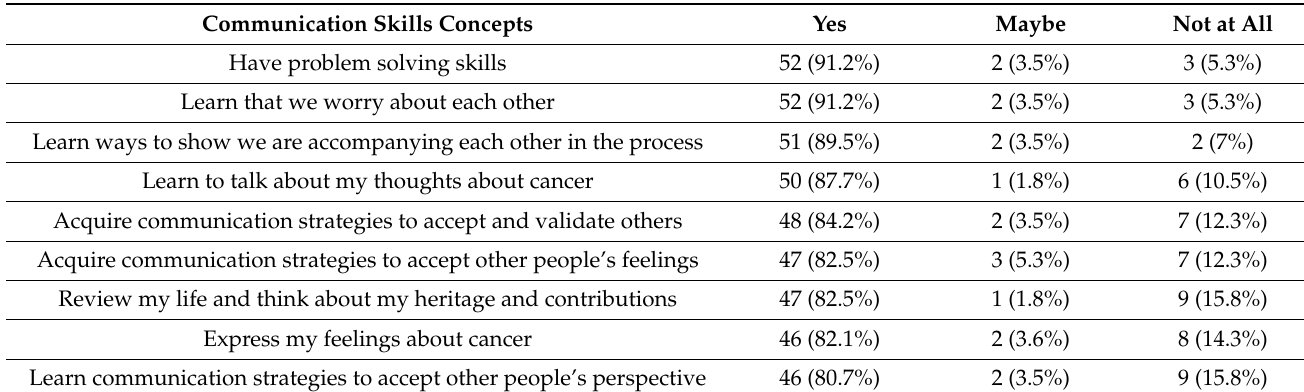
Table 10. Communication skills training concepts: